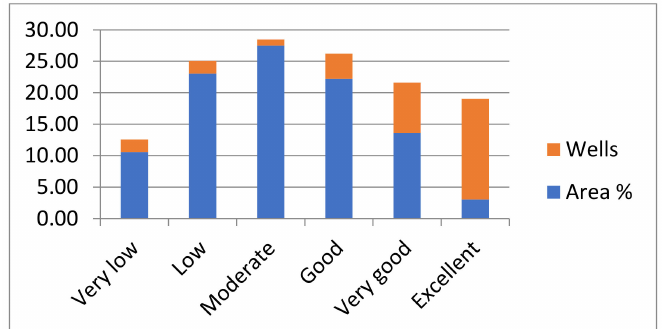
Figure 9. A column chart showing the GWPZ grades related to covered areas and the number of wells.